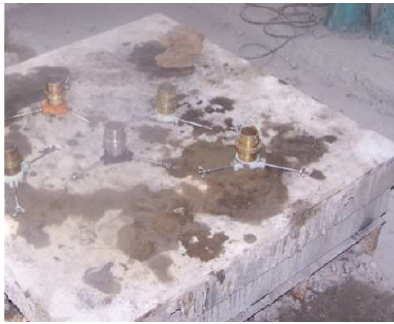
Figure 1. Layered vibration tamping with the shaking table.